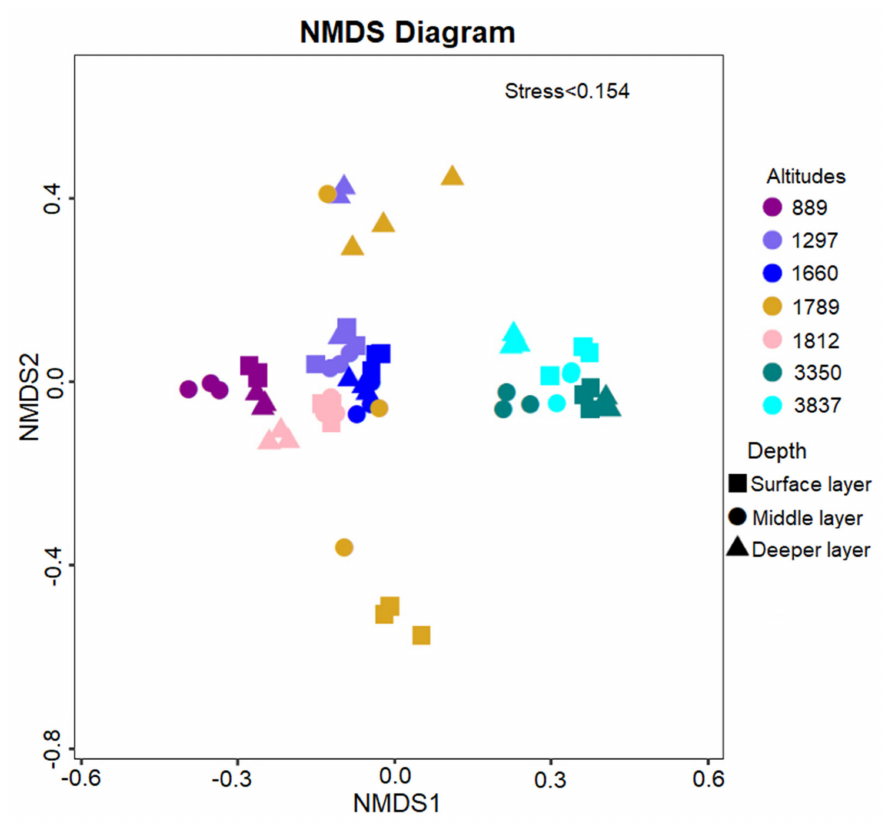
Figure 3. Fungal Community Bray–Curtis distance-based Non-Metric Multi-Dimensional Scaling plot at OTU level of soil samples among different soil layers and altitudinal